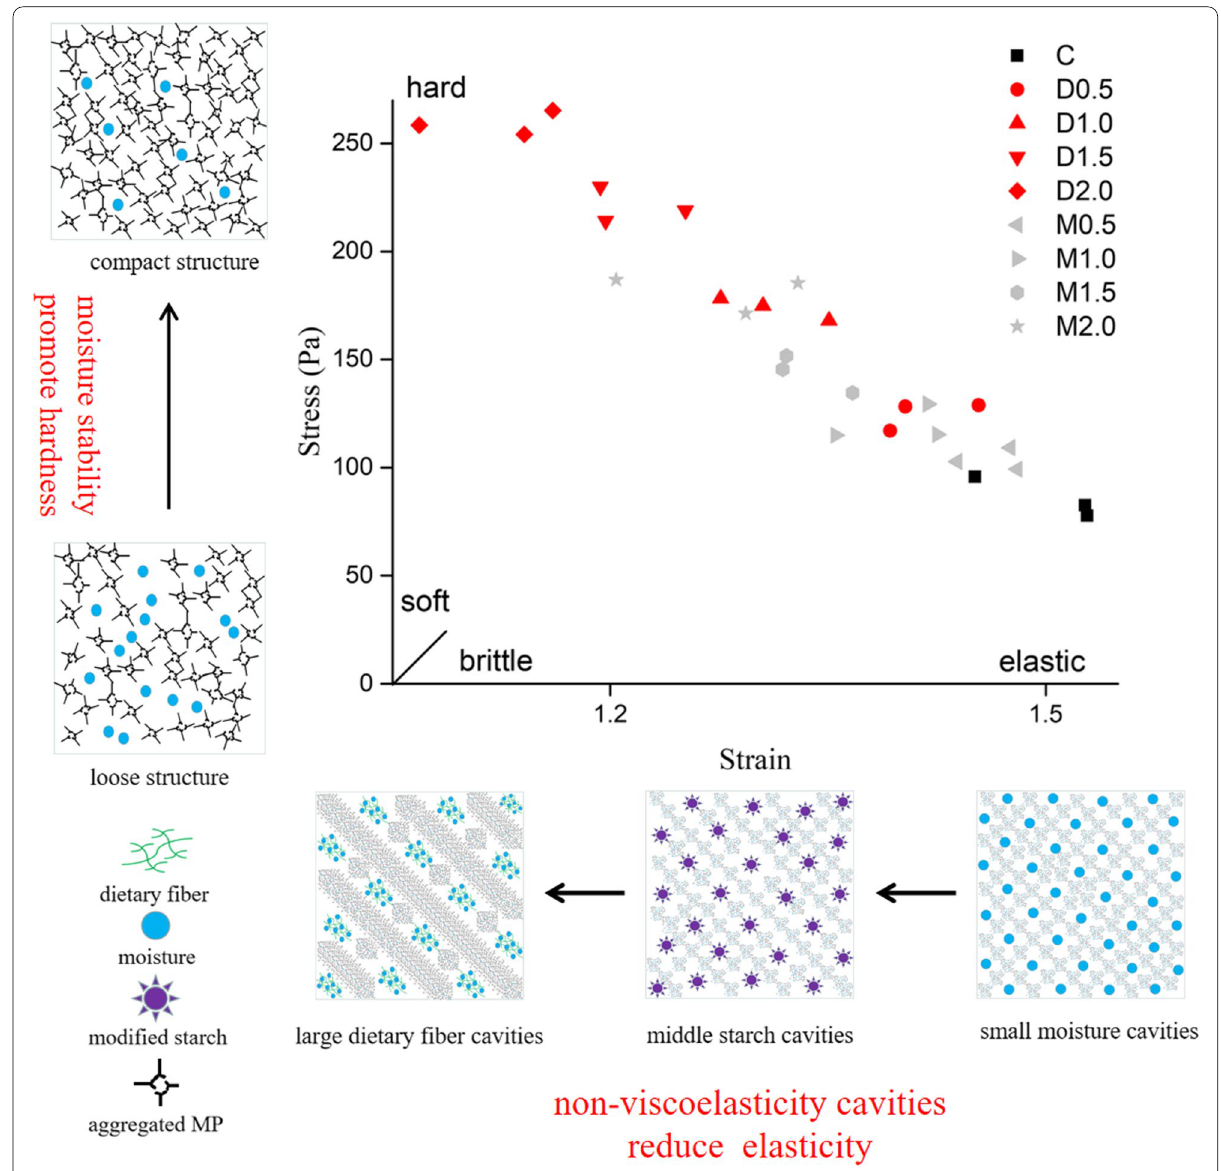
Fig. 7 The modulate relationship between fracture properties and